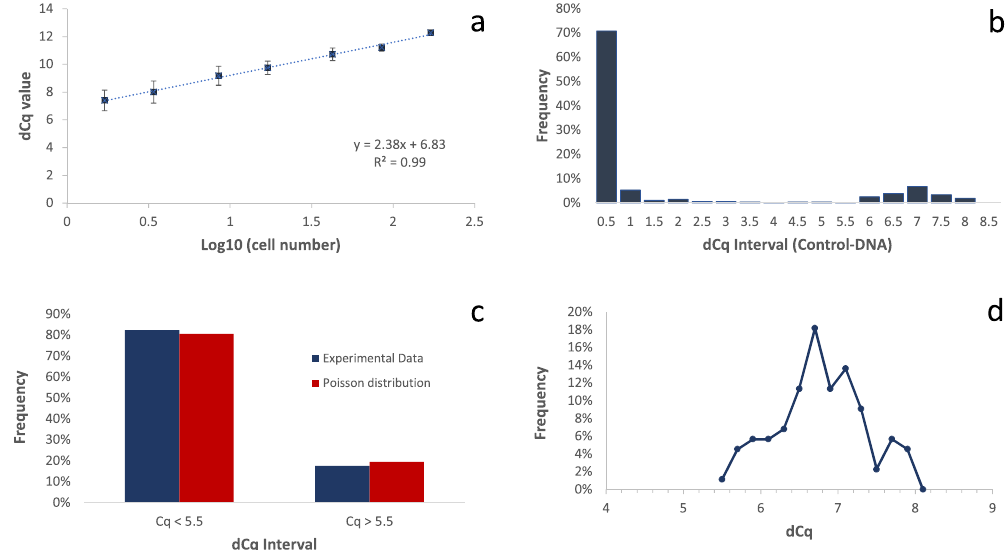
Figure 2. ( a ) Linear correlation of cell number and dCq value of Control DNA. After coWGA of various cell numbers, dCq is determined in real-time PCR. The dCq value of Control-DNA is plotted against the common logarithm (log 10 ) of cell number. The standard deviation is given as error bars. The dCq value of co-amplified Control-DNA clearly correlates with the common logarithm of cell number used in WGA. ( b) Frequency of WGA reactions characterized by dCq intervals of co-amplified Control-DNA: WGA was performed using Control-DNA and a cell dilution of 0.2 cells/WGA. As expected from Poisson distribution, most reactions did not contain any cell and resulted in a low dCq value. dCq values of ~7 represents WGA reaction containing at least a single cell. ( c) Comparison of experimental data and Poisson distribution after WGA with 0.2 cells/WGA in average. WGA reaction with dCq value < 5.5 correlated with expected fraction of WGA reactions containing 0 cells. The second cluster of WGA reactions (dCq > 5.5) correlated with expected fraction of WGA reactions containing at least one cell. ( d) Distribution of dCq value intervals of 0.2 cycles of WGA reactions containing